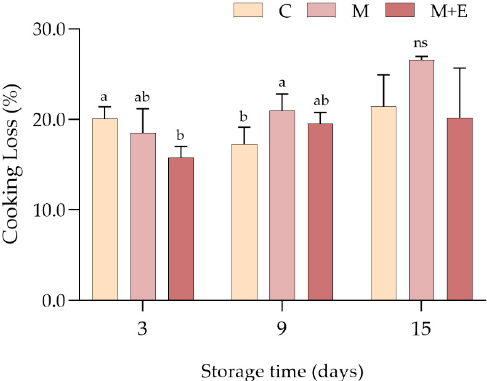
Figure 4. Average cooking loss values (%) of non-marinated (C), marinated (M) and marinated with essential oils (M + E) pork loin slices at 3, 9 and 15 days of refrigerated storage. Data represent means ± SD. a, b = average values lacking a common letter significantly differ among the same sampling time. At the same storage time, ns indicates no significant differences among the samples.